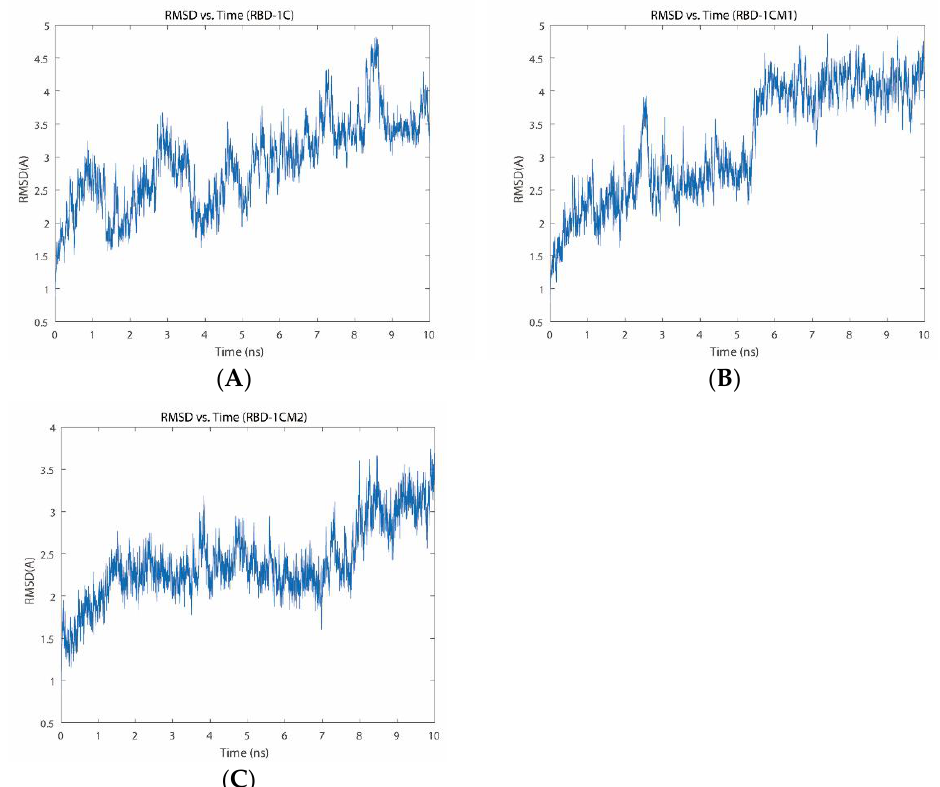
Figure 3. RMSD plots of the S protein/aptamer complexes during the MD simulation for ( A ) the S protein/RBD-1C complex, ( B ) S protein/RBD-1CM1 complex, and ( C ) S protein/RBD-1CM2 com- plex.